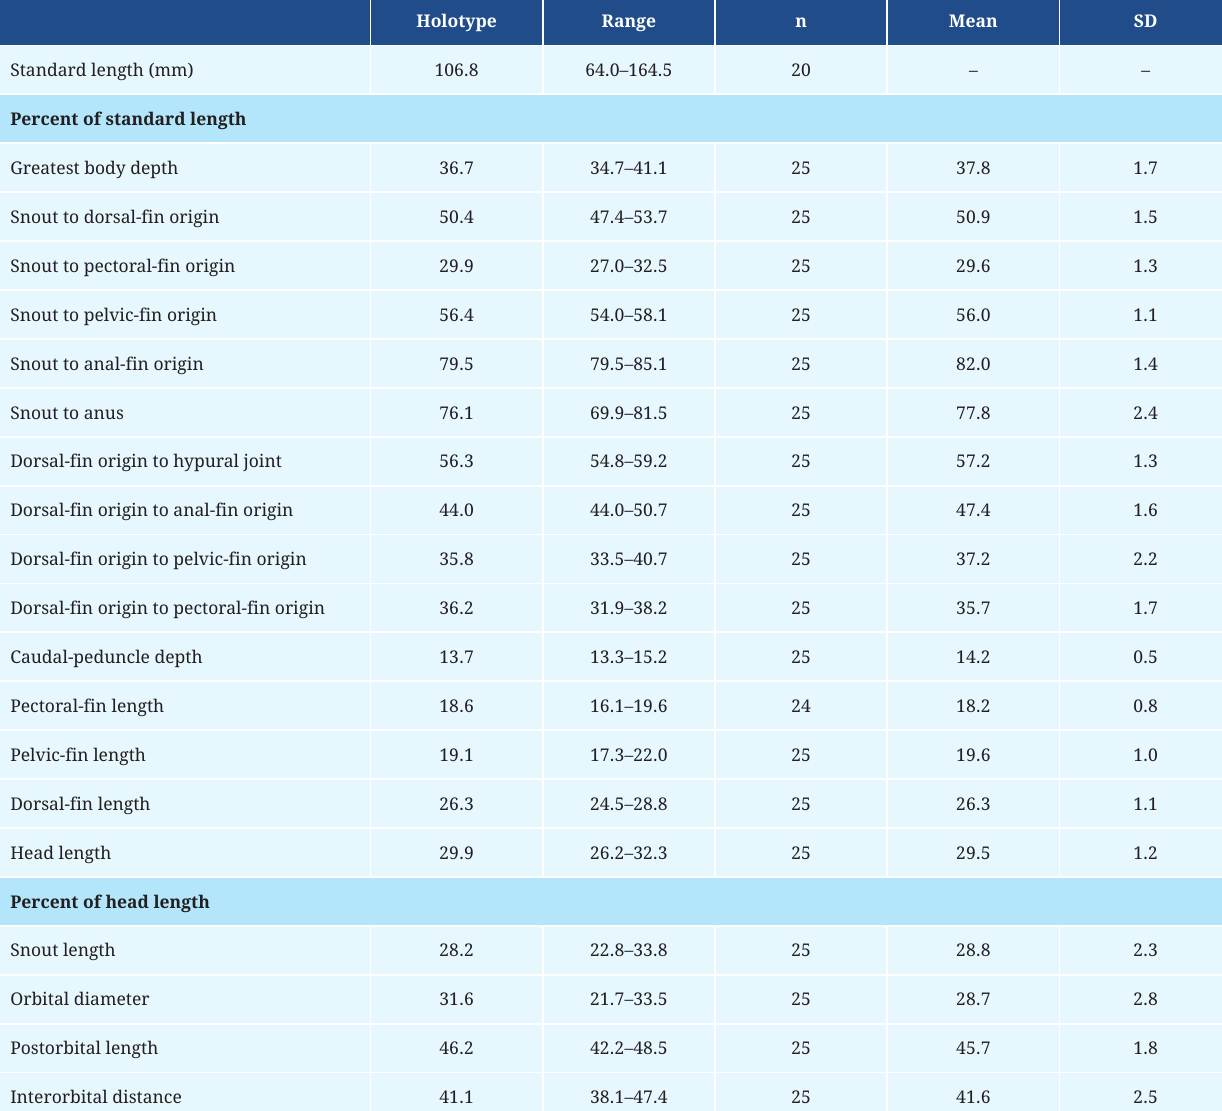
TABLE 2 | Morphometric data for Cyphocharax tamuya (n = total number of specimens examined; SD = Standard deviation); ranges include values for the